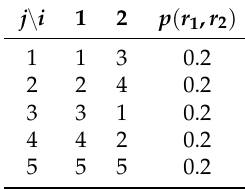
Table 5. Ranks r ij and probabilities p